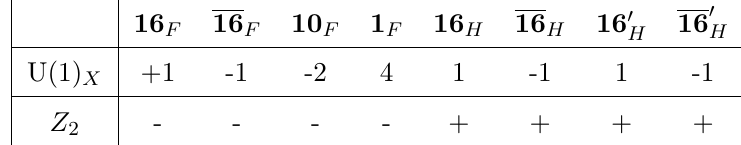
Table 2 . U(1) X and Z 2 charges of the di(cid:11)erent representations of (cid:13)ipped SO(10) gauge